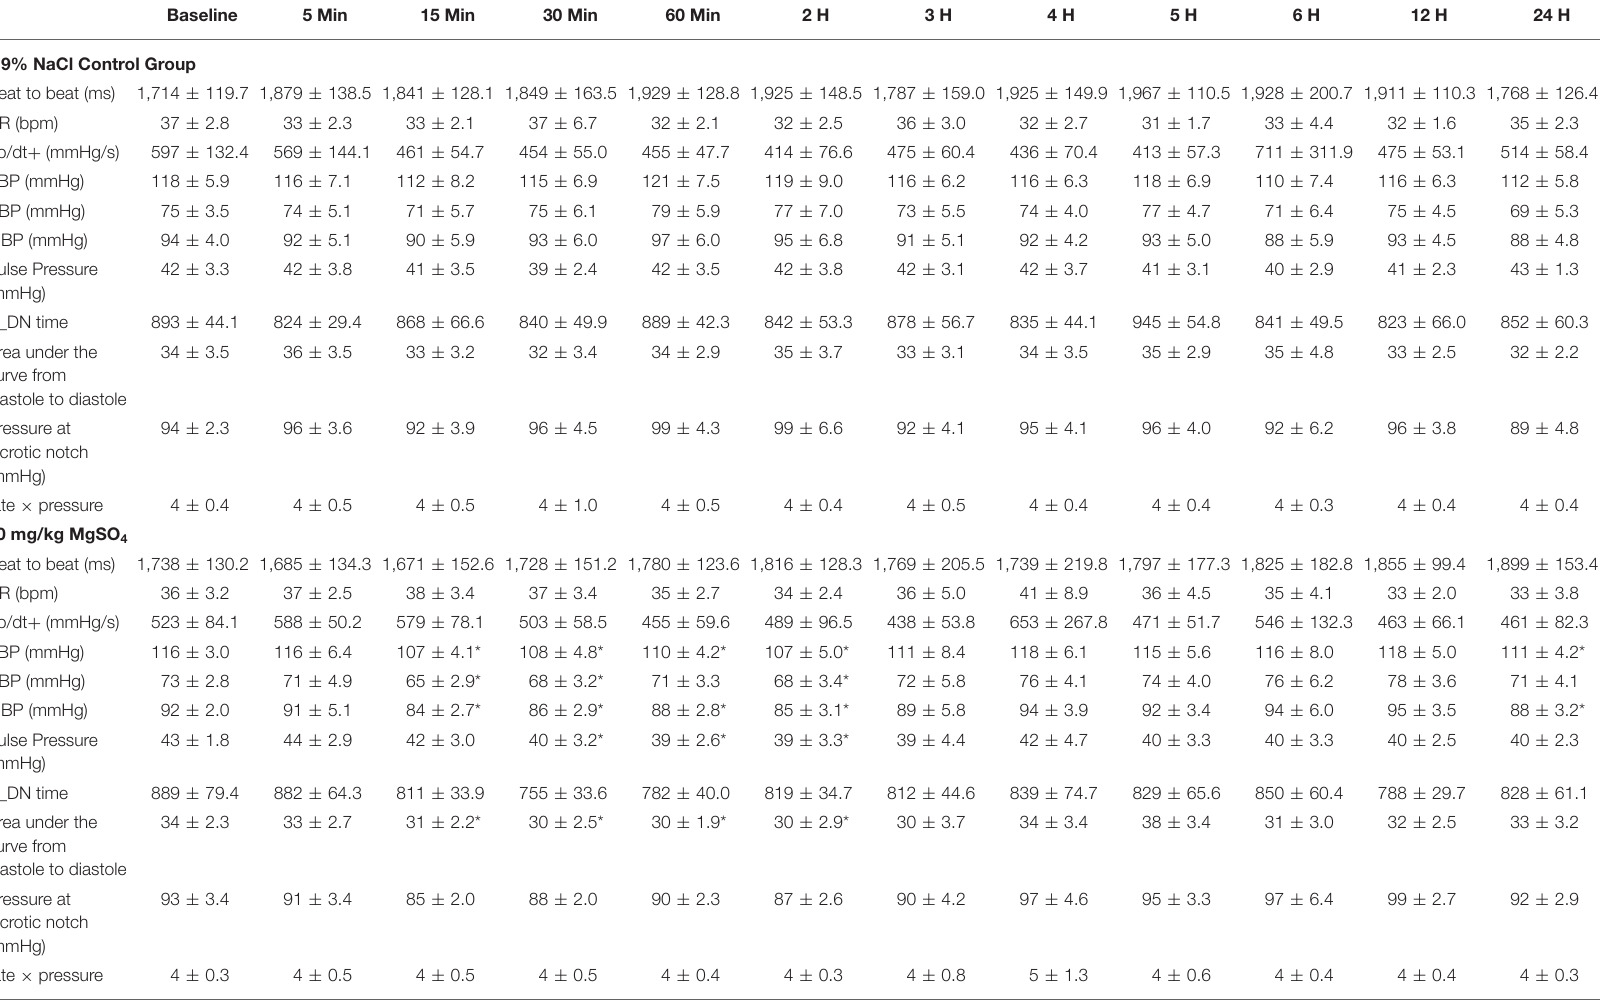
TABLE 3 | Blood pressure variables for five horses administered 60 mg/kg MgSO 4 and equal volume of 0.9% NaCl